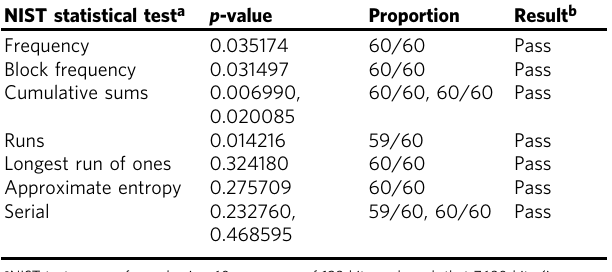
Table 1 Summary of the randomness tests of binary sequences generated from edible